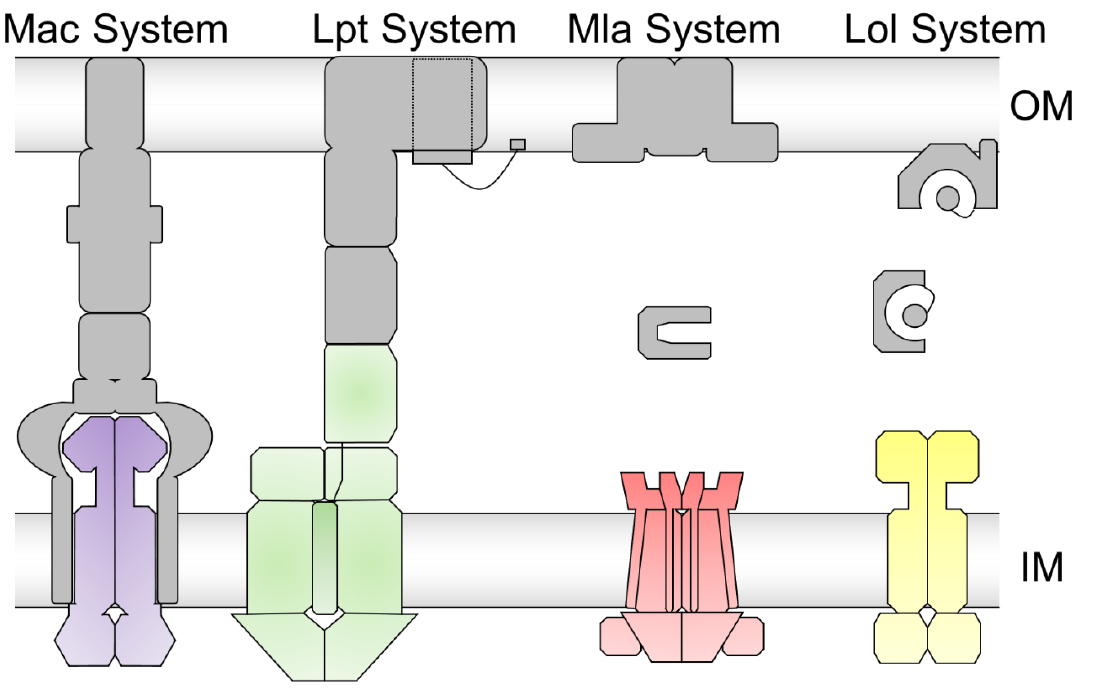
Figure 3. Schematic representation of the Mac, Lpt, Mla, and Lol system. For the Mac system, the ABC transporter MacB is shown in purple. The membrane fusion protein MacA and the outer membrane protein TolC are shown in grey. For the Lpt system, the ABC transporter LptB 2 FGC is shown in green. The periplasmic protein LptA and the translocon in the outer membrane LptDE are shown in grey. For the Mla system, the ABC transporter MlaFEDB is shown in red. The periplasmic protein MlaC and the outer membrane protein MlaA, together with OmpF, are shown in grey. For the Lol system, the ABC transporter LolCDE is shown in yellow. The periplasmic protein LolA and the outer membrane protein LolB are shown in grey. Inner membrane (IM) and outer membrane (OM) are depicted as grey bars. The peptidoglycan layer is omitted for reasons of clarity.